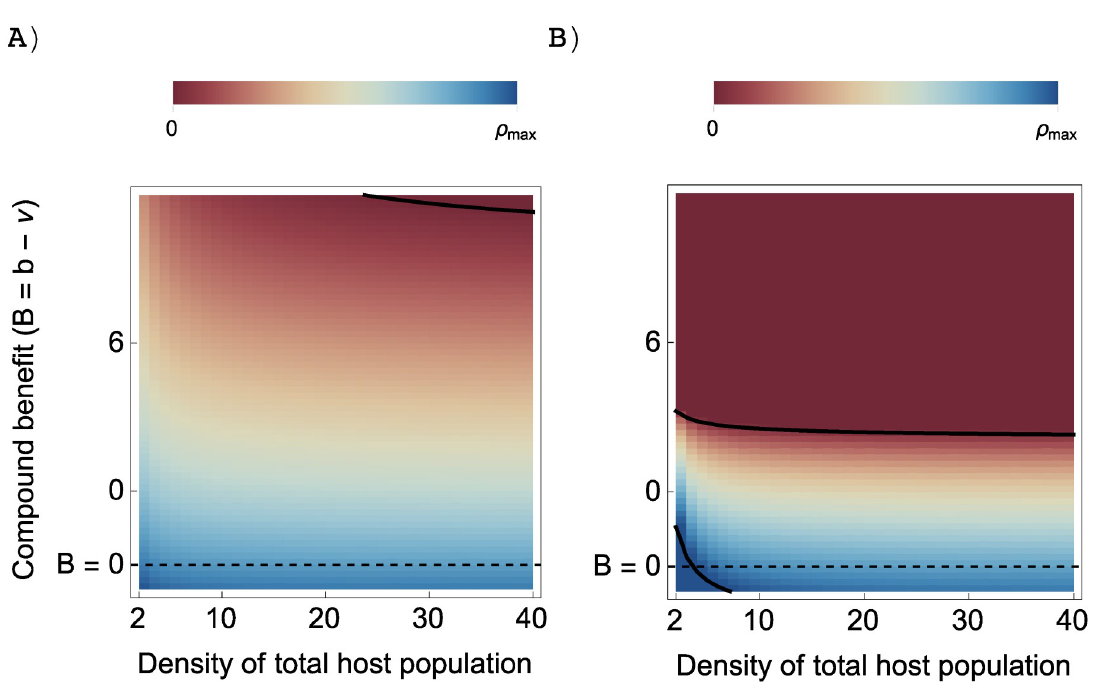
Fig 5. Effect of the compound benefit B and density of the total host population N on the transition from fully retaining independent reproduction ( ρ = ρ ) to completely forgoing independent reproduction ( ρ = 0) under cases with no vertical max transmission ( σ = 0). Trade-off is as in Fig 3. A) Convex trade-off curve where α = 0.7, δ = 1.3, B) concave trade-off curve where α = 3.1, δ = 1.3. The dashed line corresponds to the case when the symbionts gain no benefit ( b = 0). The thick lines separate the three regions: pure free-living (dark blue), obligate symbiosis (dark red) and faculative symbiosis with varying degrees of independent reproduction.